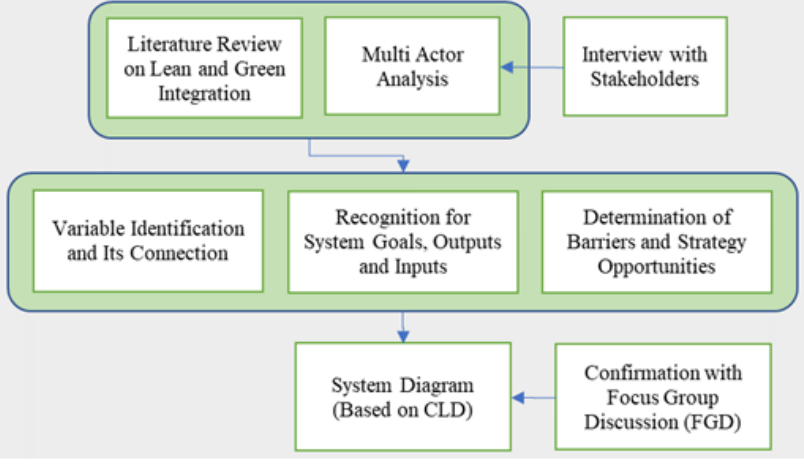
Figure 3. Steps in developing a conceptual